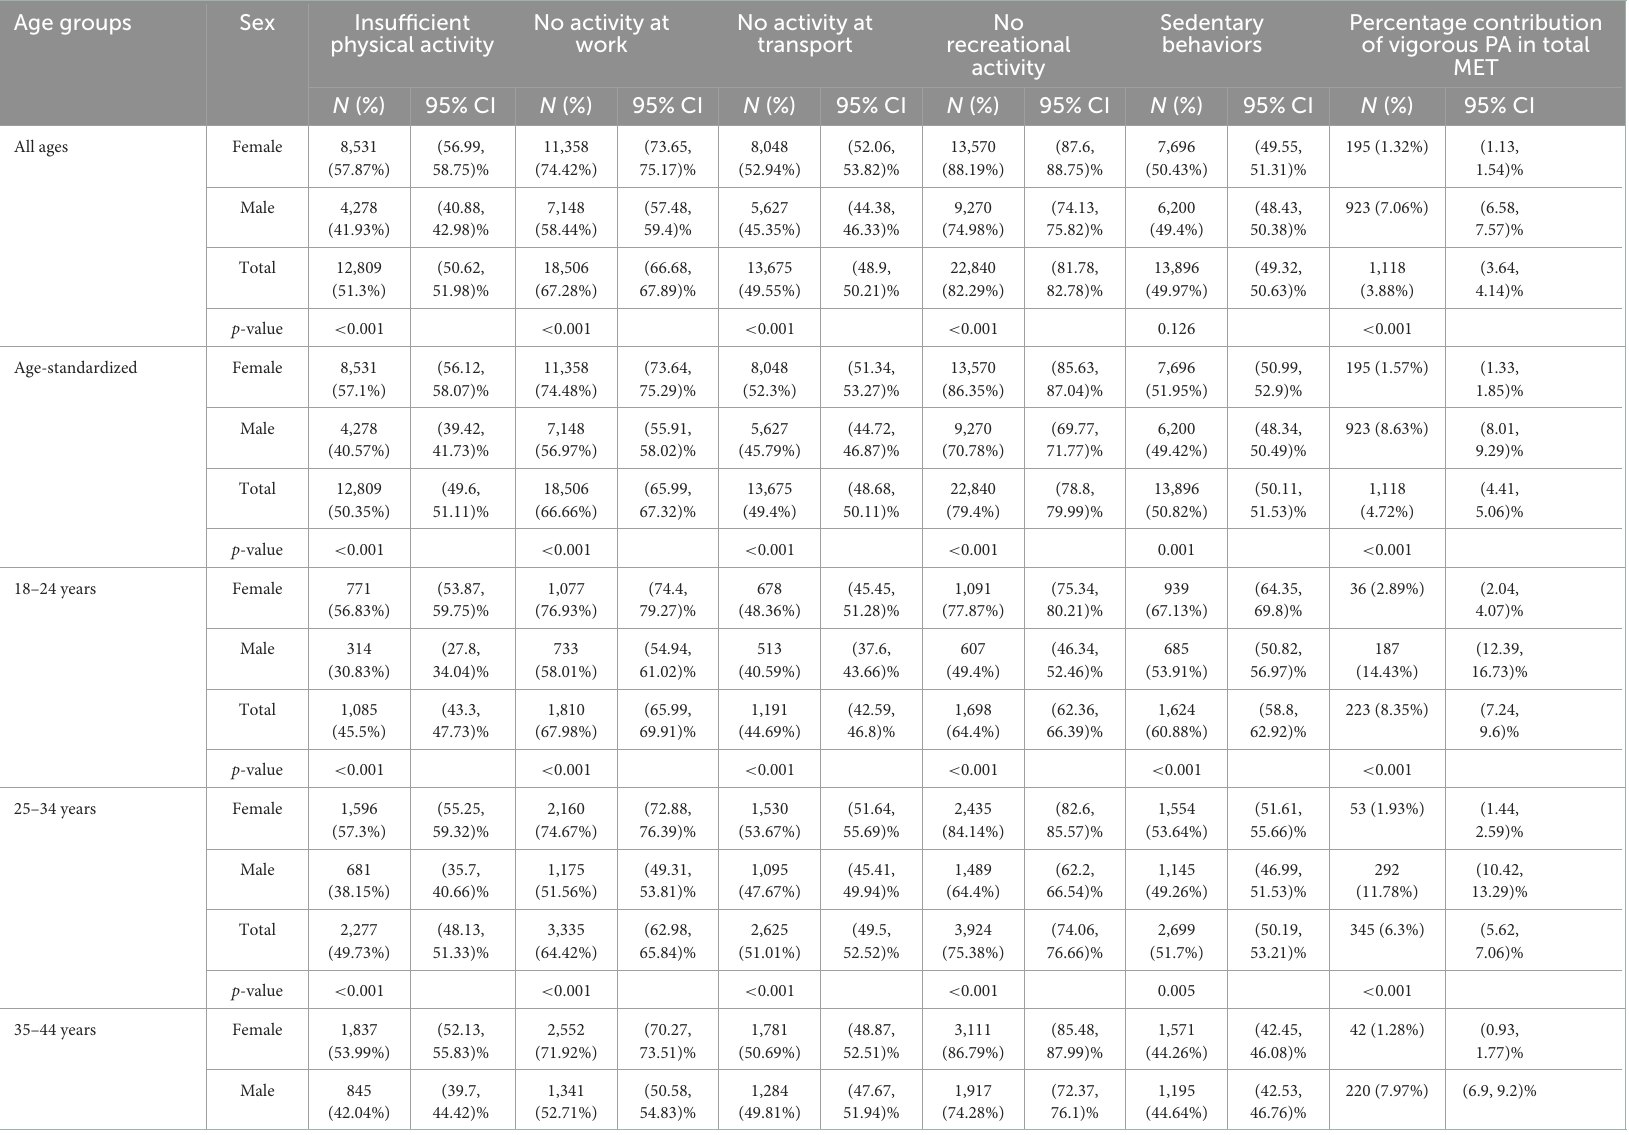
TABLE 3 Prevalence of physical activity domains, sedentary behaviors, and insufficient physical activity among women and men of various age-groups in